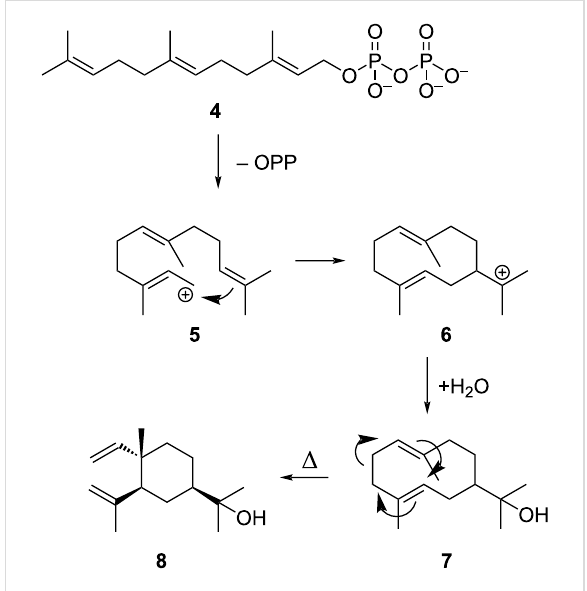
Scheme 2: Biosynthetic formation of hedycaryol ( 7 ) and α -elemol ( 8 ).